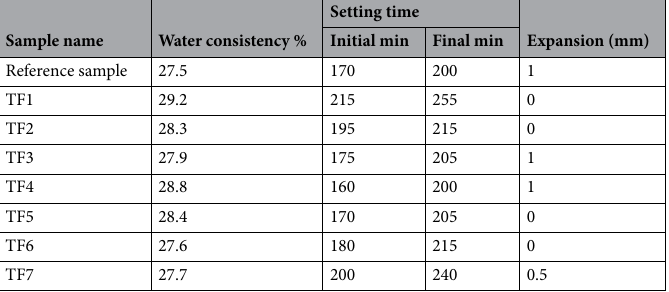
Table 4. water of consistency and Setting time for Tuff samples according to EN 196-1/2011.